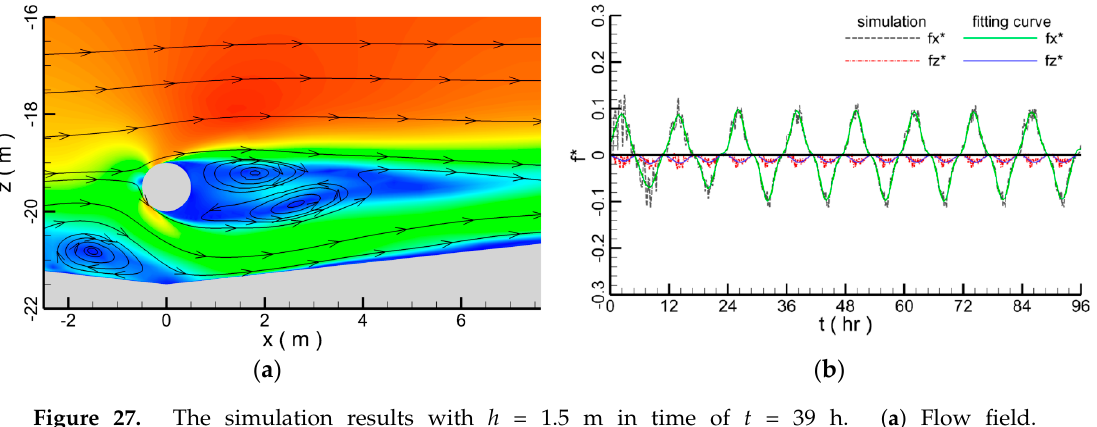
Figure 26. The simulation results with h = 0.875 m in time of t = 39 h. ( a ) Flow field. ( b ) Hydrodynamic force.